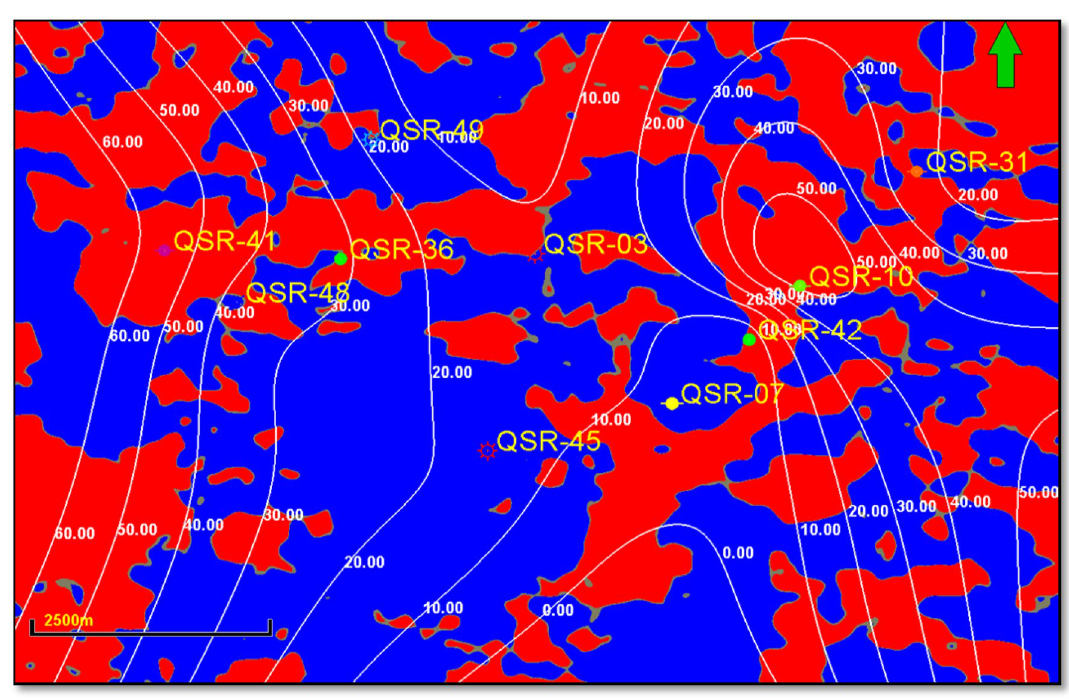
Fig. 18 Seismic horizontal section (time slice) at − 1995 ms. overlain by white isolith sand contour lines (ft.). Positive amplitude is displayed in blue color, and negative amplitude is displayed in red color